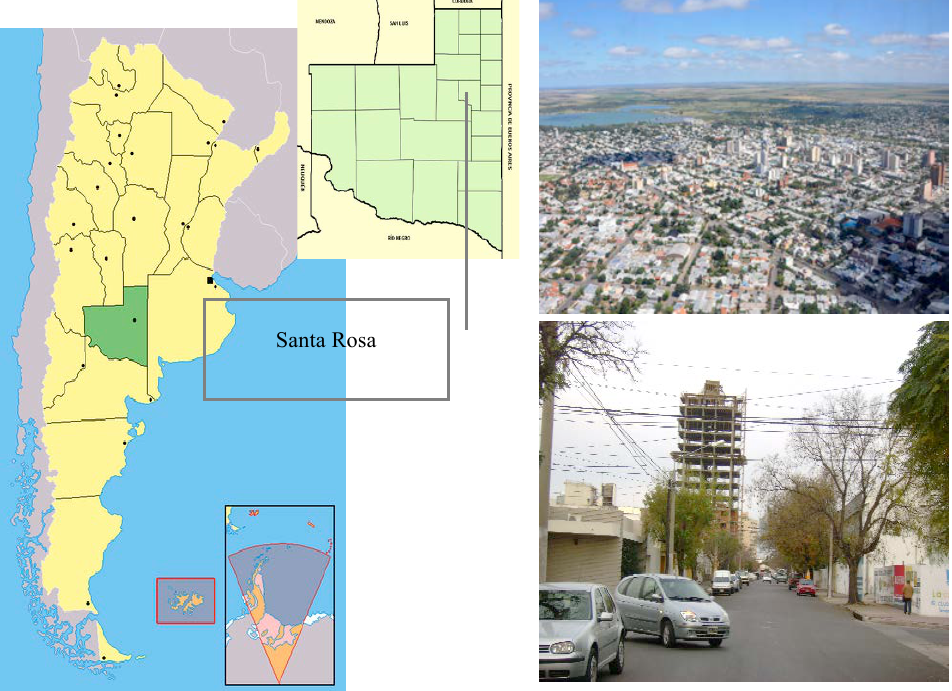
Figure 1. Localization of Santa Rosa and a panoramic view. The picture in the lower right shows the change in the profile of the urban edification and the morphology of the